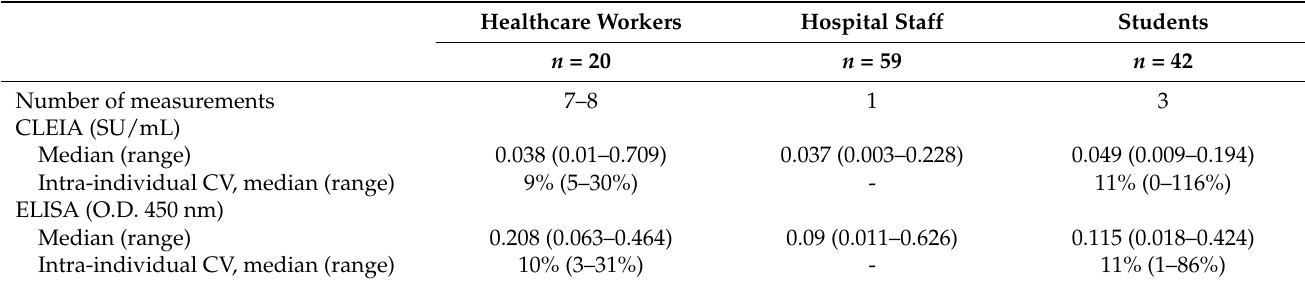
Table 2. Level of IgG antibody for SARS-Cov-2 virus nucleocapsid protein. Healthcare